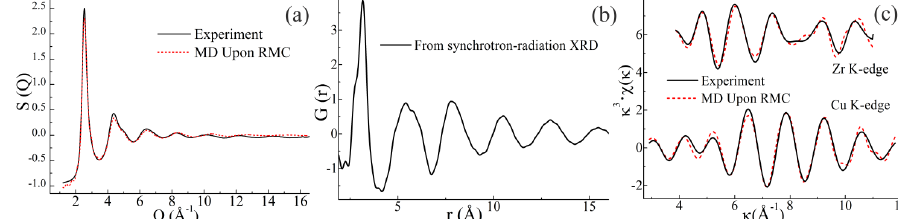
Figure 1. Synchrotron radiation data of a Zr 2 Cu sample, including: ( a ) structural factor S(Q), ( b ) pair distribution function G(r), and ( c ) normalized Zr and Cu K-edge EXAFS curves. The solid and dashed lines denote the experimental data and the MD simulation upon RMC result, respectively. The κ and the χ(κ) represent the photoelectron wave vector and the κ-space EXAFS signal, respectively.